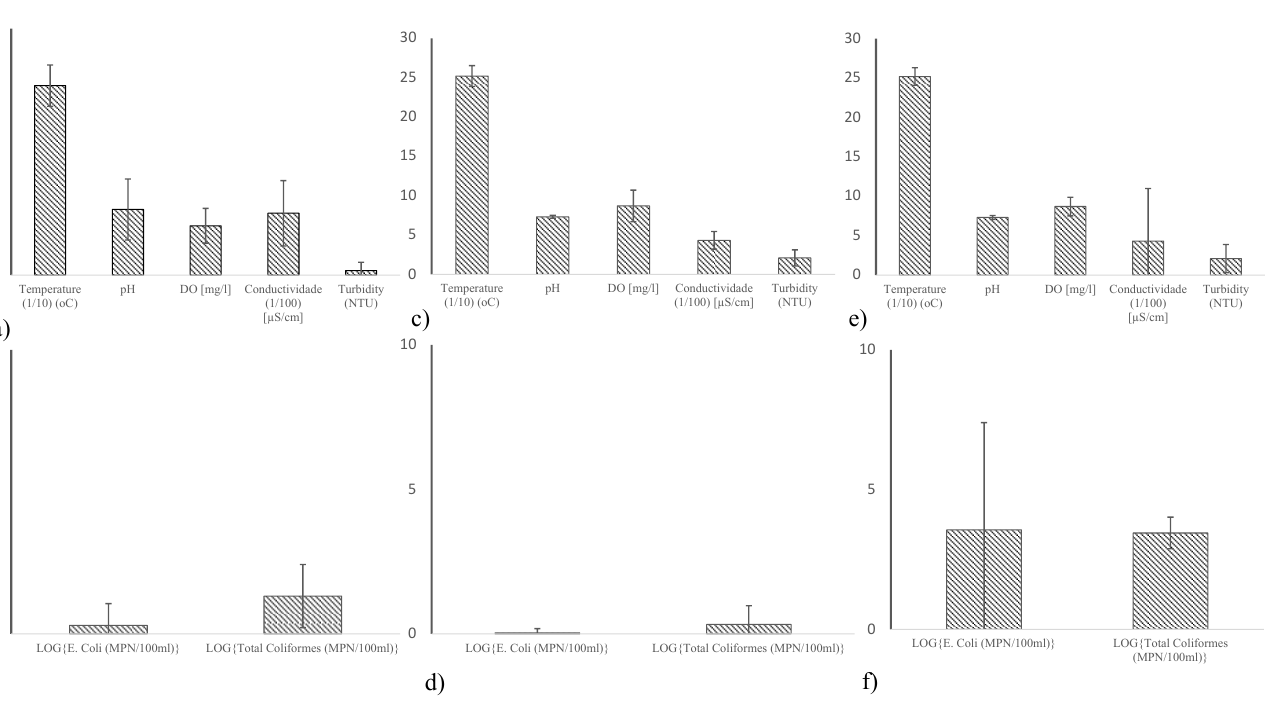
Figure 5. Results of water quality parameters from Group I: ( a ) Standard water quality parameters, including Dissolved oxygen (DO), Chemical Oxygen Demand (COD), nitrates and phosphates in river water; ( b ) Biological parameters in river water; ( c ) Standard water quality parameters, includ- ing DO, COD, nitrates and phosphates in the outlets of wastewater treatment plants (WWTPs); ( d ) Biological parameters in the outlets of WWTPs; ( e ) Standard water quality parameters, including DO, COD, nitrates and phosphates in the drainage water; ( f ) Biological parameters in the in the drainage water.